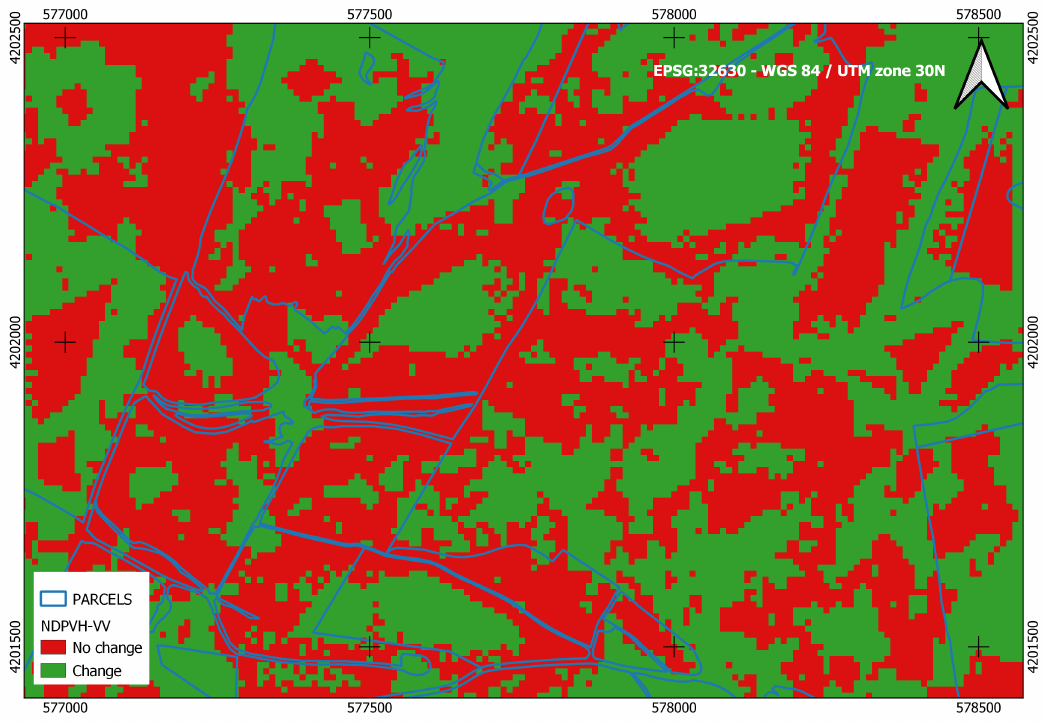
Figure 9. Map of ∆ (NDPVH-VV) as a function of the change